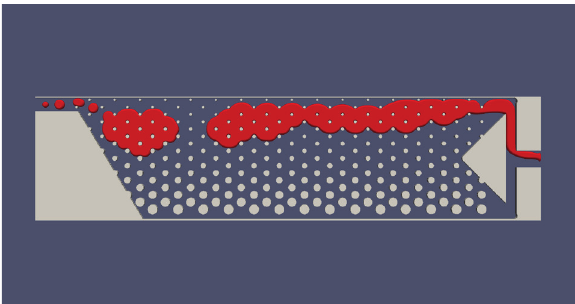
Fig. 5 – Simulation snapshot of the modified geometry. Inlet is on the left-hand side while outlet is on the right-hand side of the picture. The wetting phase is transparent, while the non-wet- ting phase is pictured red. Flow ratio wetting : non-wetting = 2:1; Re=0.27; Ca=0.024.